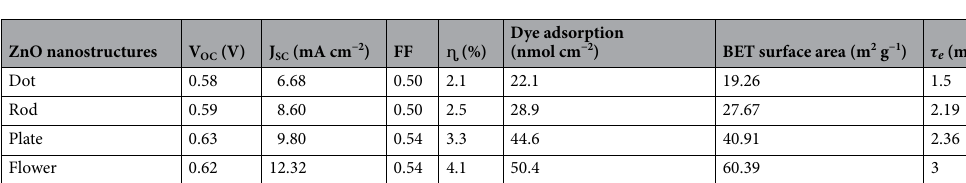
Table 2. The photovoltaic parameters of DSSCs fabricated using synthesized ZnO nanostructuresas photoanode.